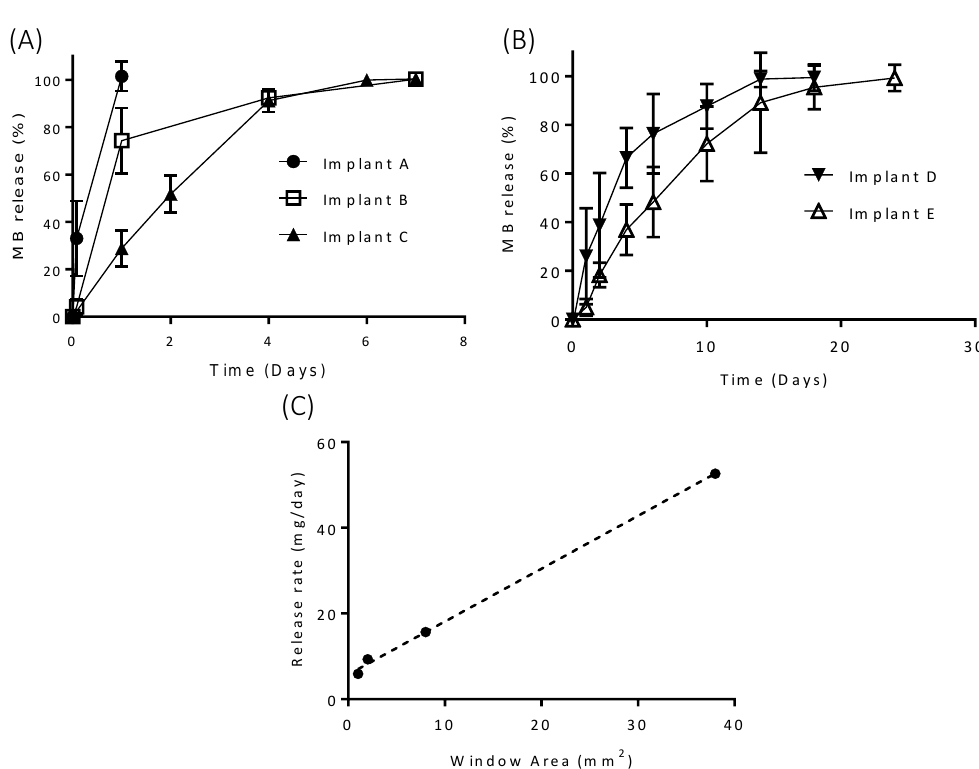
Figure 6. Release of methylene blue (MB) from ( A ) Implant A–C; ( B ) Implants D and E ( n = 3, means ± SD) and ( C ) correlation between MB release rate and “window” area for the implants. Table 1. Difference ( F 1 ) and similarity ( F 2 ) factor of each release profile for methylene blue (MB) release from poly(lactic acid) (PLA) implant with poly(vinyl alcohol) (PVA) “window” designs. Curve 1